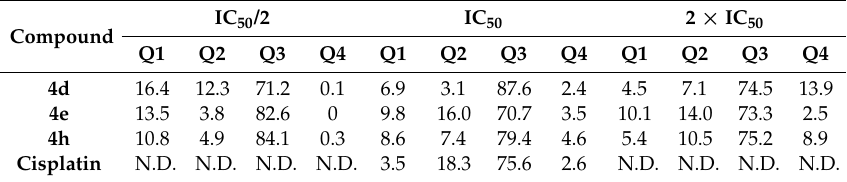
Table 2. The flow cytometric analysis results of compounds 4d , 4e , and 4h and cisplatin for C6 cell line.